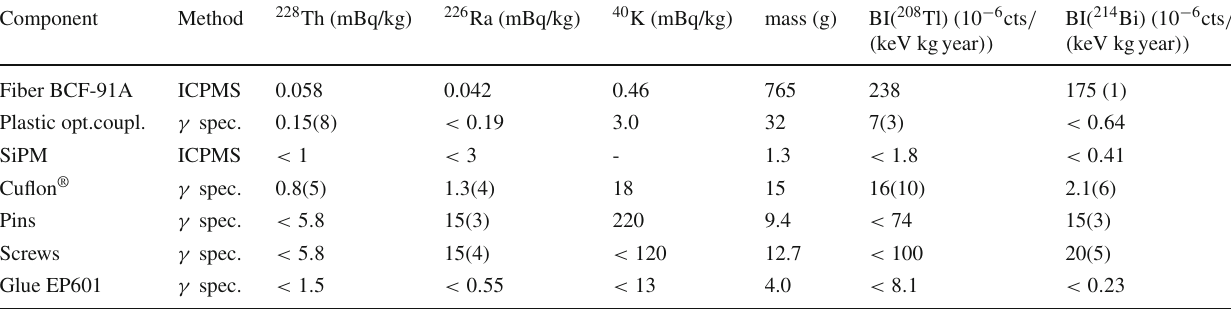
Table 10 Activity of the components of the fiber-SiPM LAr veto system and their estimated background contribution BI at Q ββ after anti- coincidences but before the LAr veto and PSD Component